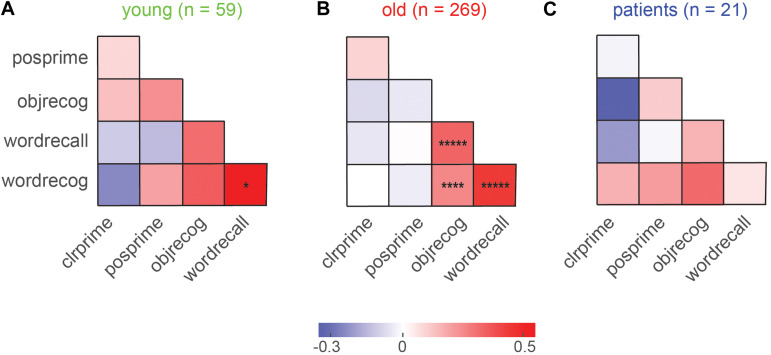
Covariation in explicit and implicit memory across participants. (A) Pairwise correlation between explicit and implicit memory measures for young participants. Legends: clrprime: color priming strength, posprime: position priming strength, objrecog: object recognition accuracy, wordrecall: word recall accuracy, wordrecog: word recognition accuracy. Each entry indicates the Pearson’s correlation coefficient between a given pair of memory measures across participants. Asterisks indicate statistical significance of these correlations (Conventions as before). (B) Same as (A), but for older participants. (C) Same as (A), but for MCI patients.